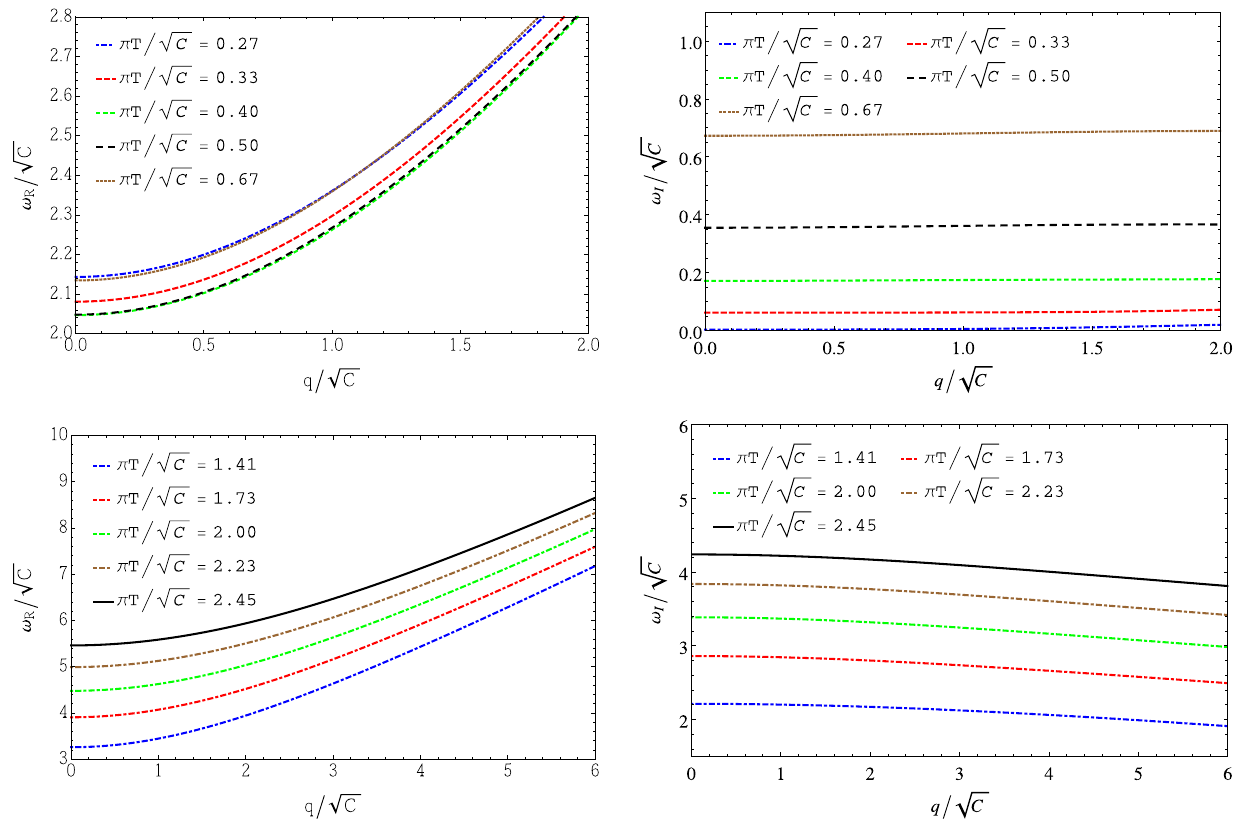
Fig. 11 Dispersion relations for low temperatures (top panels), intermediate and high temperatures (bottom panels) for G = 1